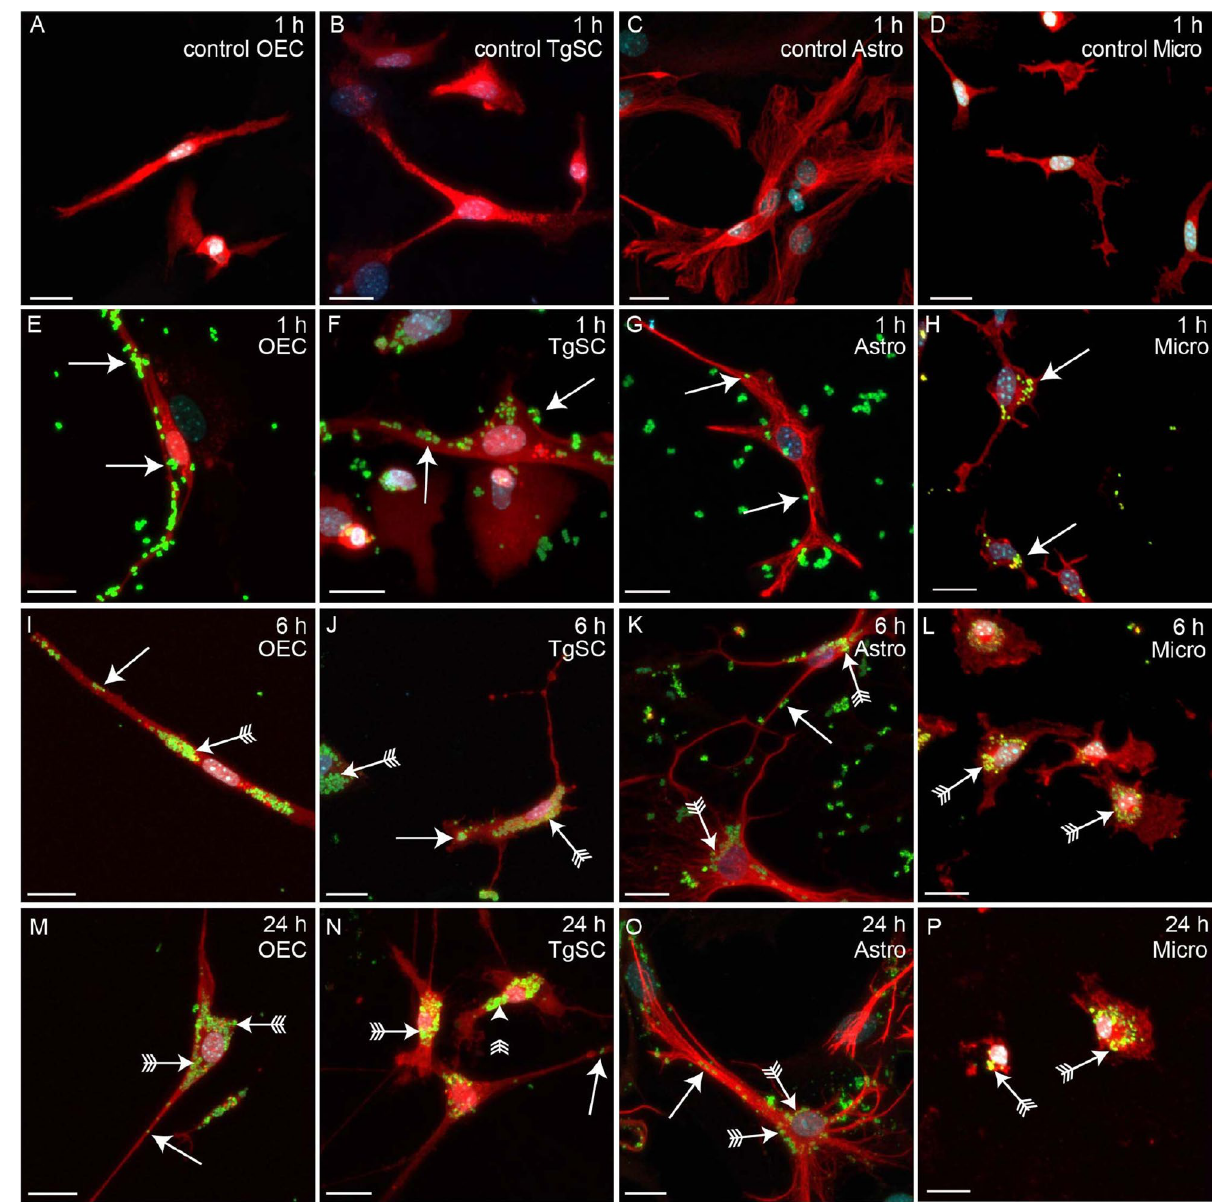
Figure 1. S. aureus attaching to and being internalised into OECs, TgSCs, astrocytes and microglia. Panels show primary cultures of OECs (left panels), TgSCs (second panels), astrocytes (third panels) and microglia (right panels) from S100β-DsRed mice, in which all glia express the DsRed protein. For OECs and TgSCs, red labelling shows DsRed; for astrocytes, red labelling shows GFAP (these cells express low levels of DsRed); for microglia, red labelling shows Iba-1 (these cells express low level of DsRed) and Hoechst for nucleus staining. ( A – D ) Control wells of the four glial types 1 h post addition of medium without bacteria and antibiotics. ( E – H ) At 1 h post exposure to S. aureus , bacteria had adhered to the cell surface (arrow) and internalized (arrow) within the microglia. ( I – P ) After 1 h, antibiotics were added, preventing survival of bacteria in the medium. ( I – L ) S. aureus in glia at 6 h post exposure, some bacteria were present in the processes (arrows) while larger amounts accumulated in the perinuclear region (arrows with tail). ( M – P ) At 24 h post exposure, most bacteria were present in the perinuclear region (arrows with tail) while some bacteria were also present in the processes (arrows). Scale bar: 20 as compared to astrocytes (Fig. 2C). We analysed the invasion frequency (the percentage of the initially adhered bacteria that were inside cells at 6 h); there was no significant difference in invasion frequency between cell types (Fig. 2E). We also determined the percentage of bacteria that survived intracellularly (amount of bacteria isolated from inside cells at 24 h compared to 6 h) and found no significant difference (Fig. 2F). To account for changes in cell numbers during the assay (proliferation or death), a cell count was performed and intracellular survival was calculated on the cell numbers at 24 h (OECs, TgSCs and astrocytes showed no significant change in cell